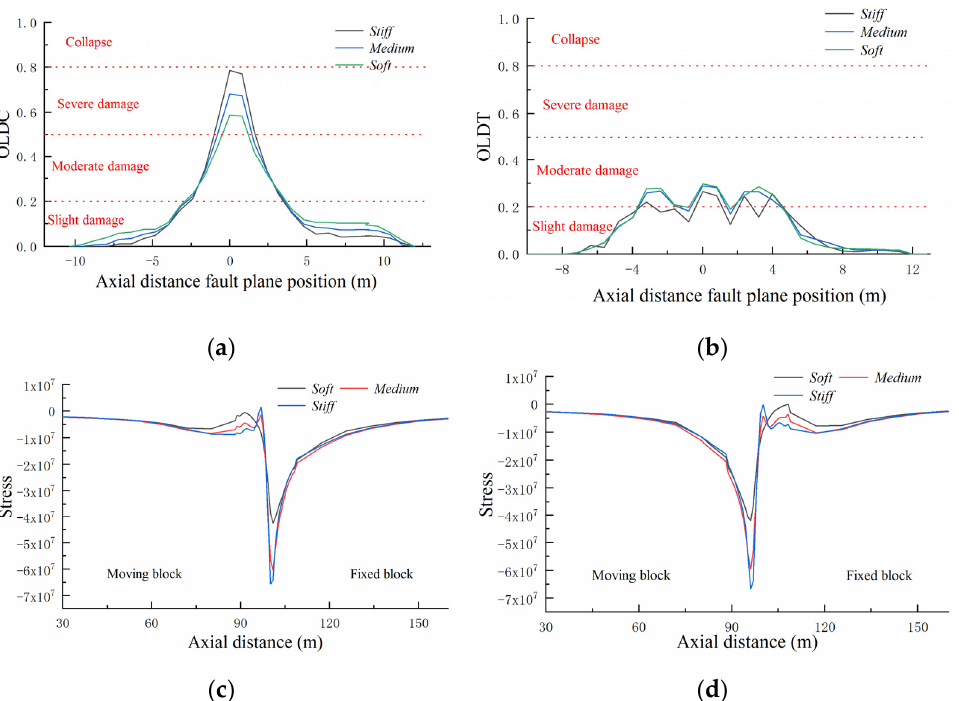
Figure 14. Axial overall damage distribution curves of concrete with different surrounding rock properties in the fault fracture zone ( Δ f = 8 cm and β = 60°) and axial stress curve of concrete vault and invert ( a ) OLDC, ( b ) OLDT, ( c ) vault and ( d ) invert.